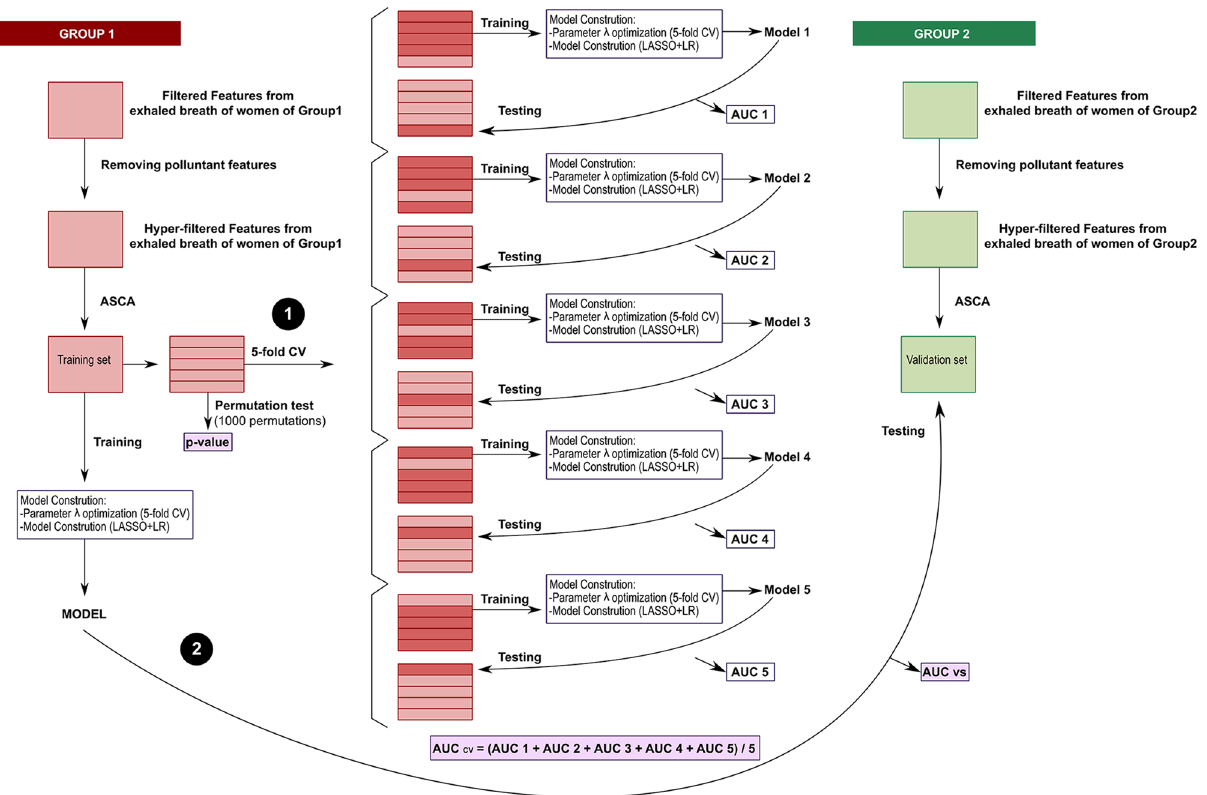
Figure 6. Data modeling workflow. The performance of the models was assessed by two approaches: (1) fivefold cross-validation and (2) testing in the validation set. CV cross-validation, ASCA ANOVA-simultaneous component analysis, LASSO least absolute shrinkage and selection operator, LR logistic regression, AUC area under the receiver operating characteristic curve, AUC cv AUC obtained by fivefold cross-validation, AUC vs AUC obtained by testing in the validation